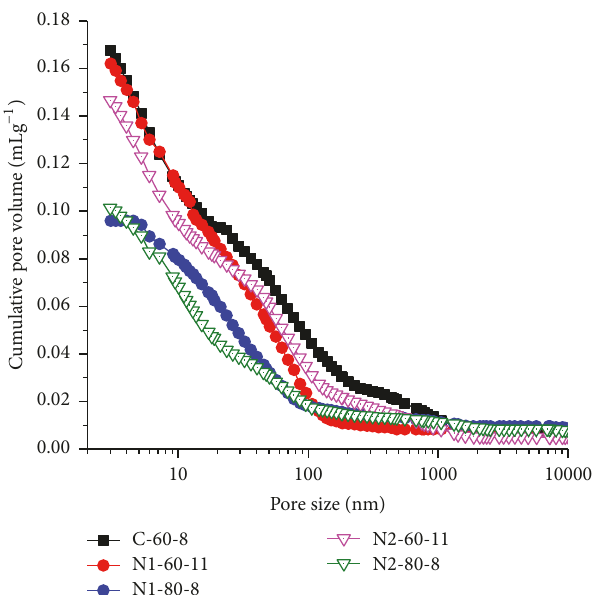
Figure 16: Compressive strength of the standard-cured concrete with W/B of 0.4.